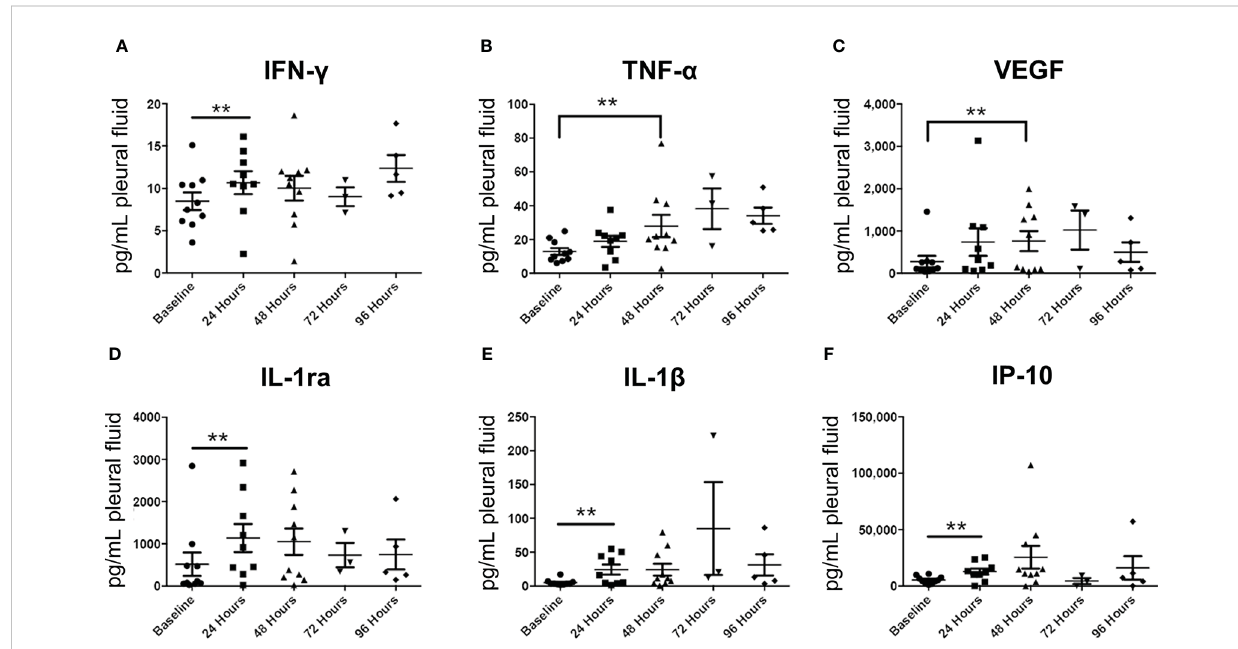
FIGURE 8 Pleural fl uid cytokine pro fi les before and after Olvi-vec therapy. (A – F) Pleural fl uid sampled before and after Olvi-vec therapy (at 24 hours, 48 hours, 72 hours, and 96 hours post-treatment) was evaluated for concentrations of cytokines. Bars indicate mean and SEM. **p<0.05, paired